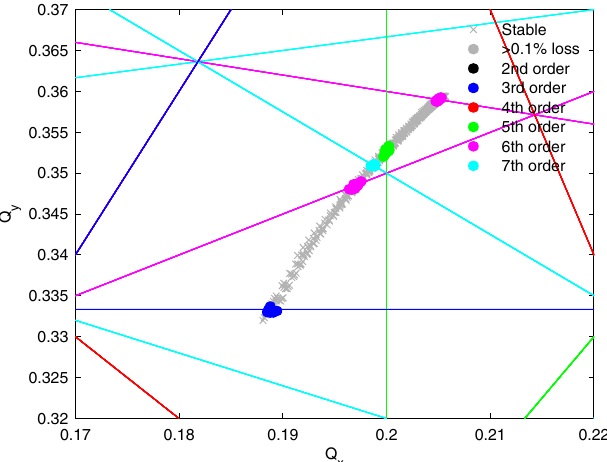
FIG. 4. Frequency map for the Diamond storage ring obtained from the model after including in the fit the systematic multi- polar errors in the main dipoles. See text for explanation.